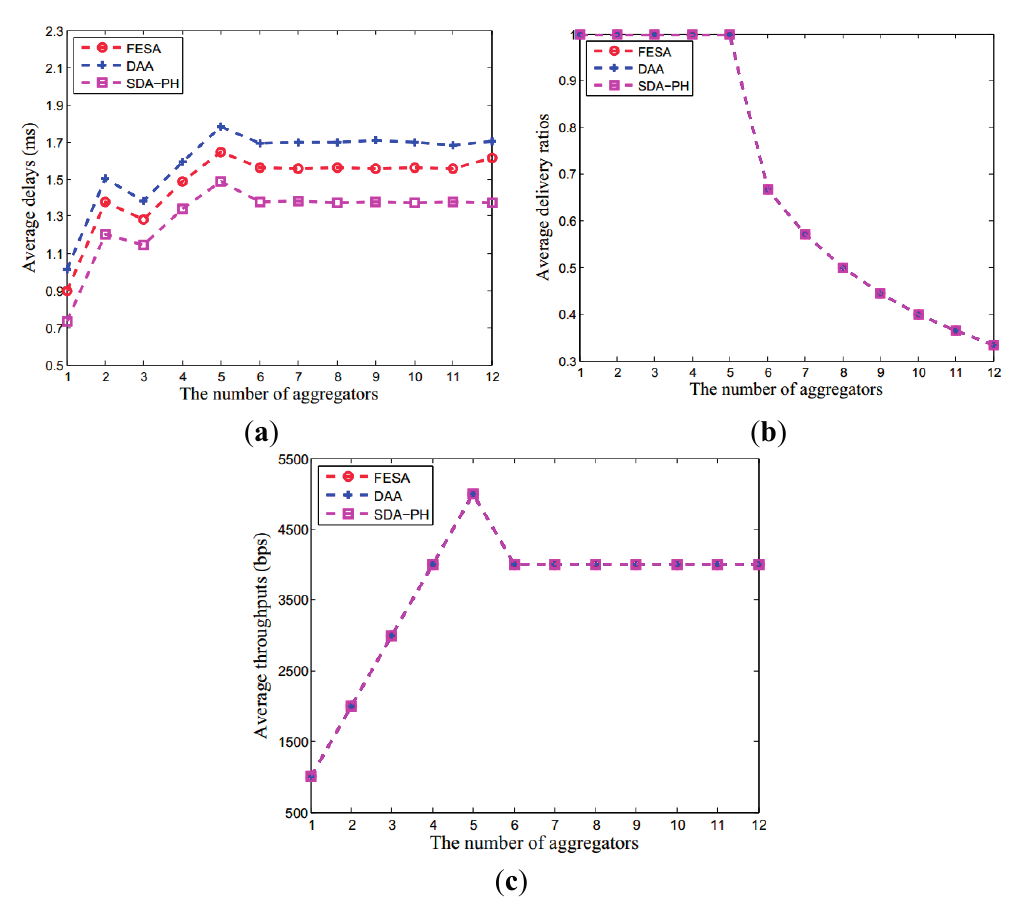
Figure 7. The entire network performance under DAA, SDA-PH and our scheme. Although using FHE increases the communication overhead, the performance of our scheme is still approaching to the other two schemes. ( a ) The average delay of the entire network; ( b ) The average delivery ratios of the entire network; ( c ) The average throughput of the entire network. In ( b ), when there are less than six aggregators forward data to the base station at the same time, the data delivery ratios are close to